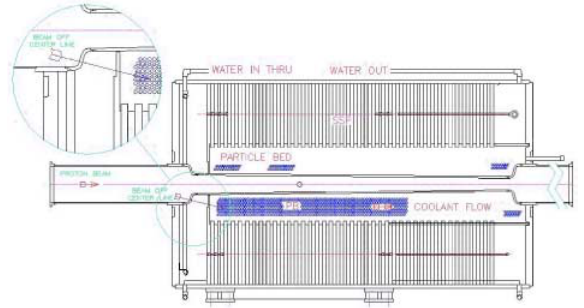
FIG. 6. (Color) View of the absorber structure.